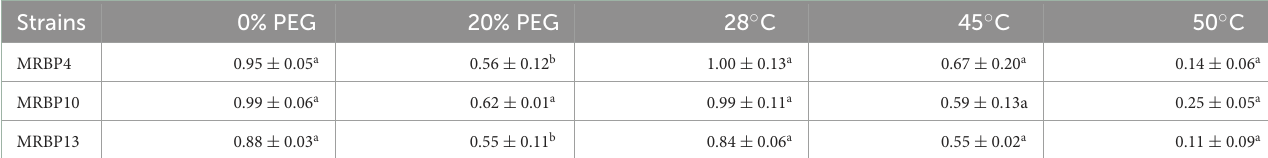
TABLE 3 Effect of PEG and temperatures on growth of rhizobacteria strains.